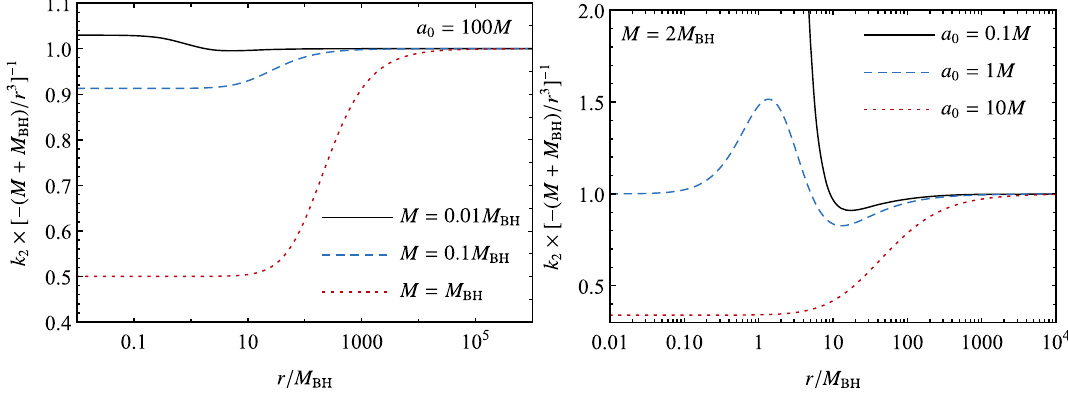
Fig. 9 Normalizedtidaltensorcomponent k 2 ,forBHswithanisotropic matter, as a function of the radius, for some representative cases. We use the same parameter space as the one described in Fig. 8, considering, in